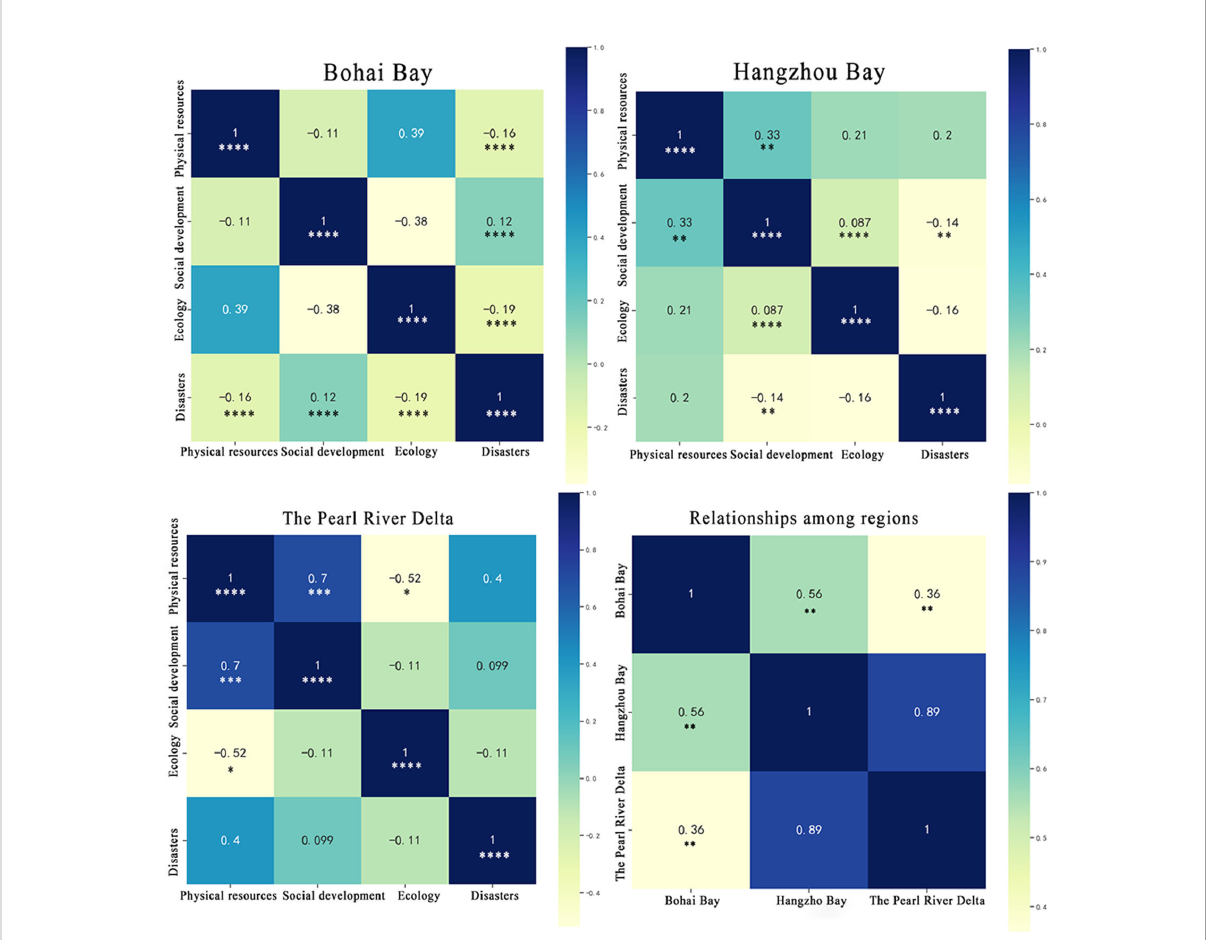
FIGURE 5 The interactive relationships between sub-resilience systems in and among three bay areas. t signi fi cance test below the value (*p<0.05, **p<0.01, ***p<0.001, and ****p<0.0001). The correlations among the four sub-resilience systems show signi fi cant spatial heterogeneity in Chinese bay